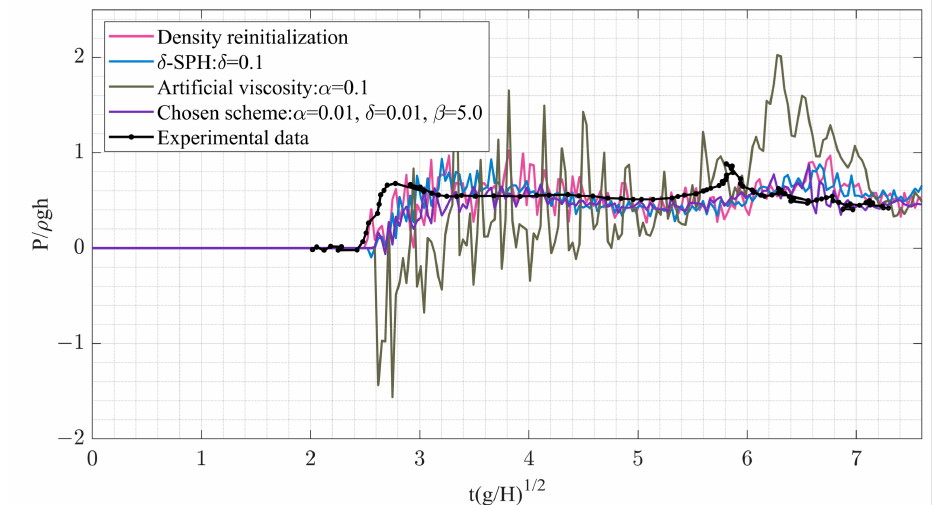
Figure 3. Comparison of the interpolated pressure data at the measurement location against the experimental measurements for different numerical dissipation schemes using WC4 kernel. The pressure and the time values have been non-dimensionalized by using P